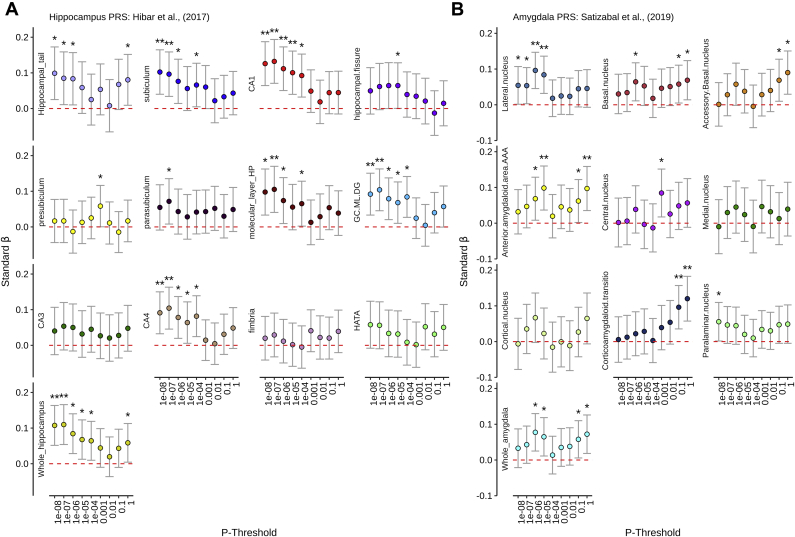
Positive control results: standardized β coefficients (Y-axis) for (A) hippocampus and (B) amygdala PRS (controlling for demographic and genetic confounds) across a range of p thresholds (X-axis). ∗Nominal significance (pUNCORRECTED < 0.05), ∗∗Survival for FDR (pFDR < 0.05).